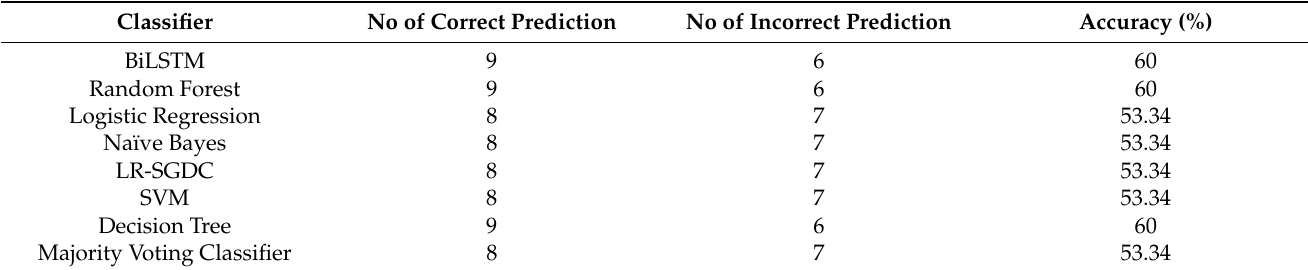
Table 10. Prediction by first dataset.